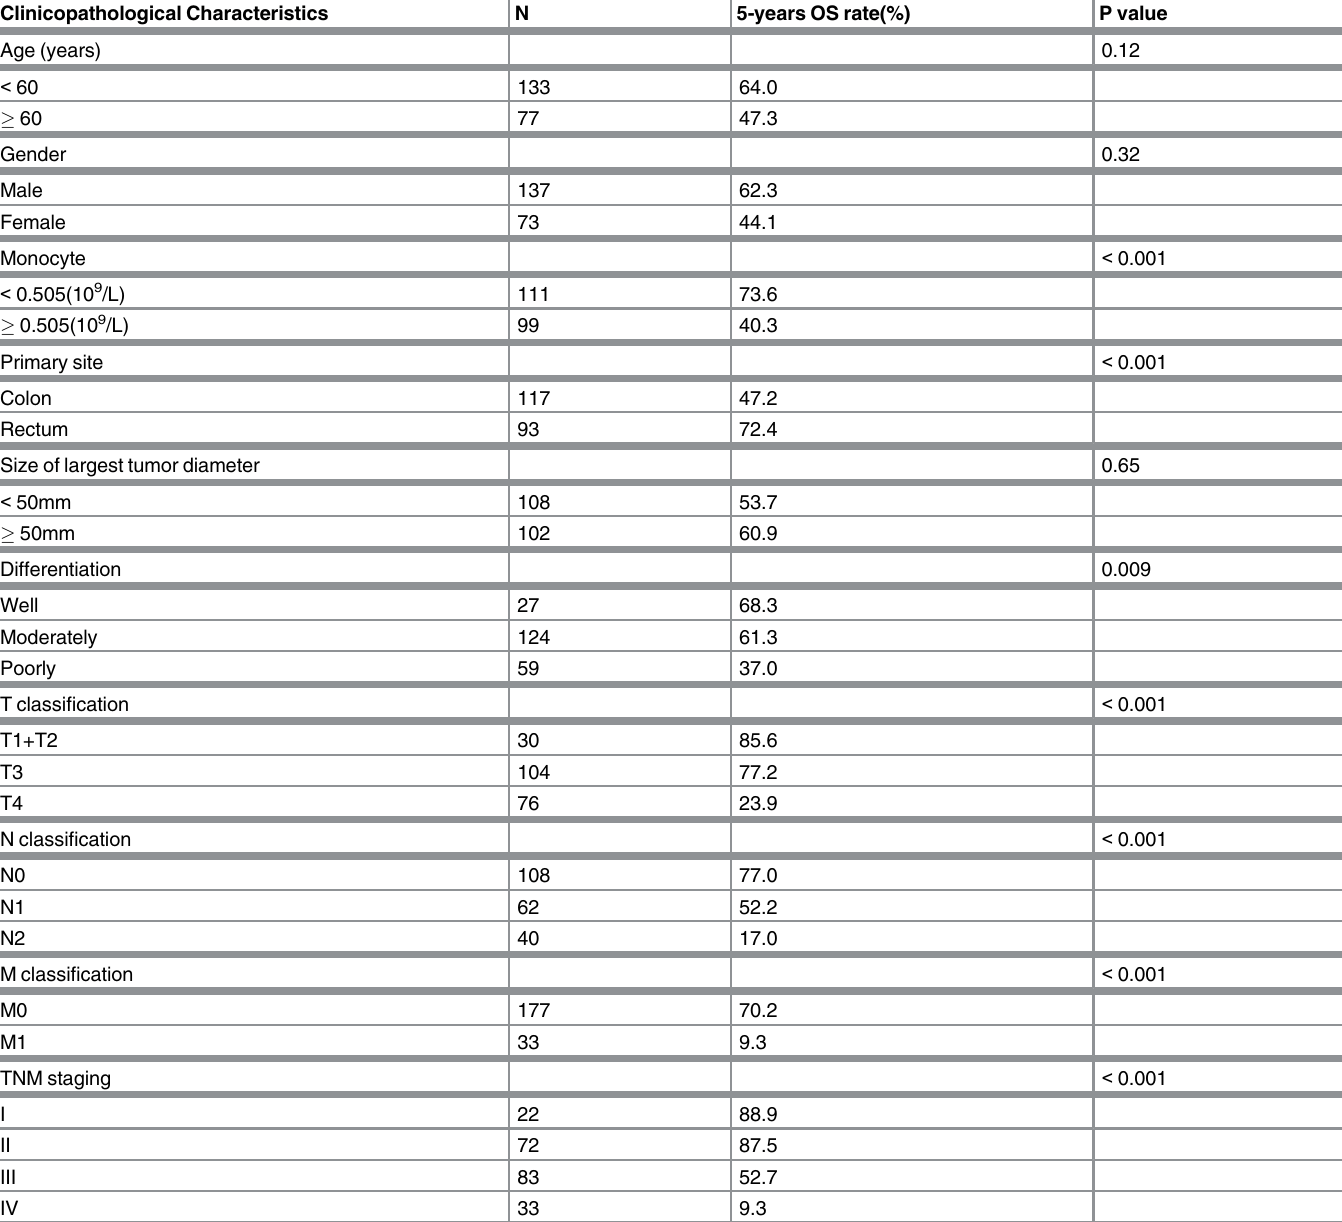
Using the prognostic factors from the univariate analyses and the clinically significant factors, we performed a Cox regression analysis. The preoperative peripheral blood monocyte count, Table 3. Univariate analysis for prognosis in 210 patients with colorectal